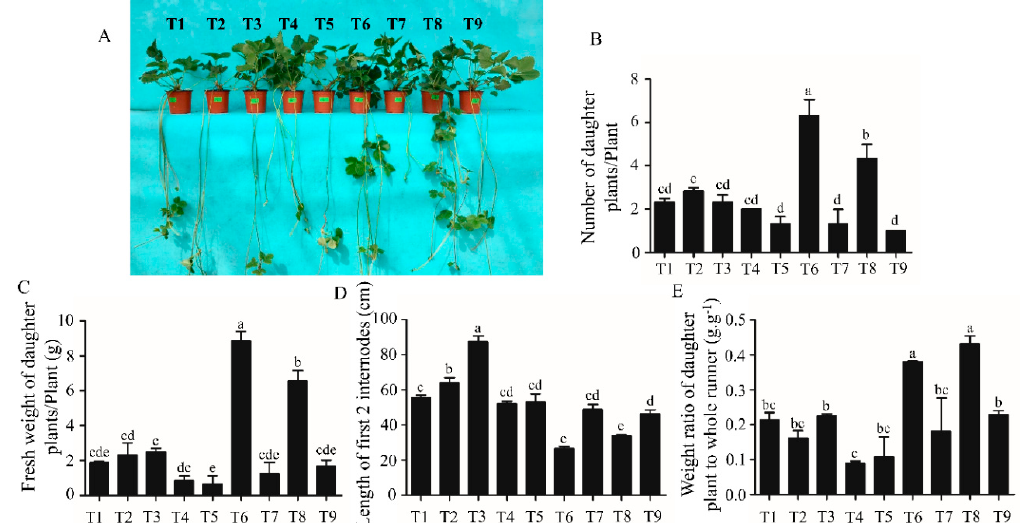
Figure 3. The morphological and growth parameters of the strawberry plants after a 5-week cultivation in a glasshouse. ( A ) Morphology of the strawberry plants; ( B ) number of daughter plants per plant; ( C ) fresh weight of daughter plants; ( D ) length of the first 2 internodes; ( E ) weight ratio of the daughter plant to the whole runner. Data are presented as the mean ± standard error ( n = 3). Lowercase letters indicate the significant difference according to Duncan’s multiple range test at a 0.05 level.